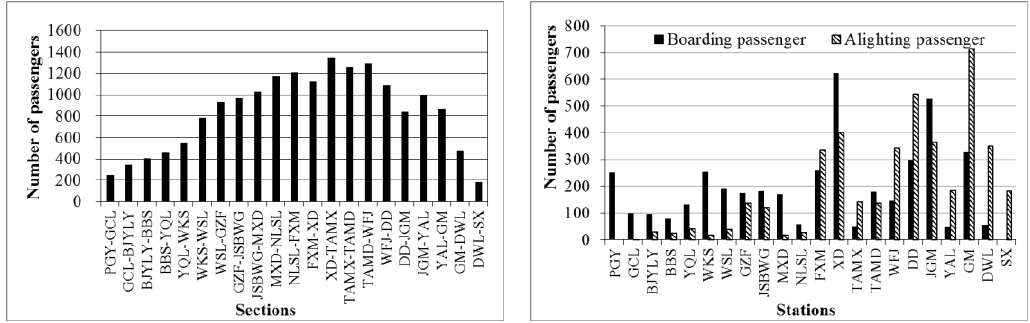
Figure 7. Load passenger of a train Figure 8. Boarding and alighting passengers at stops